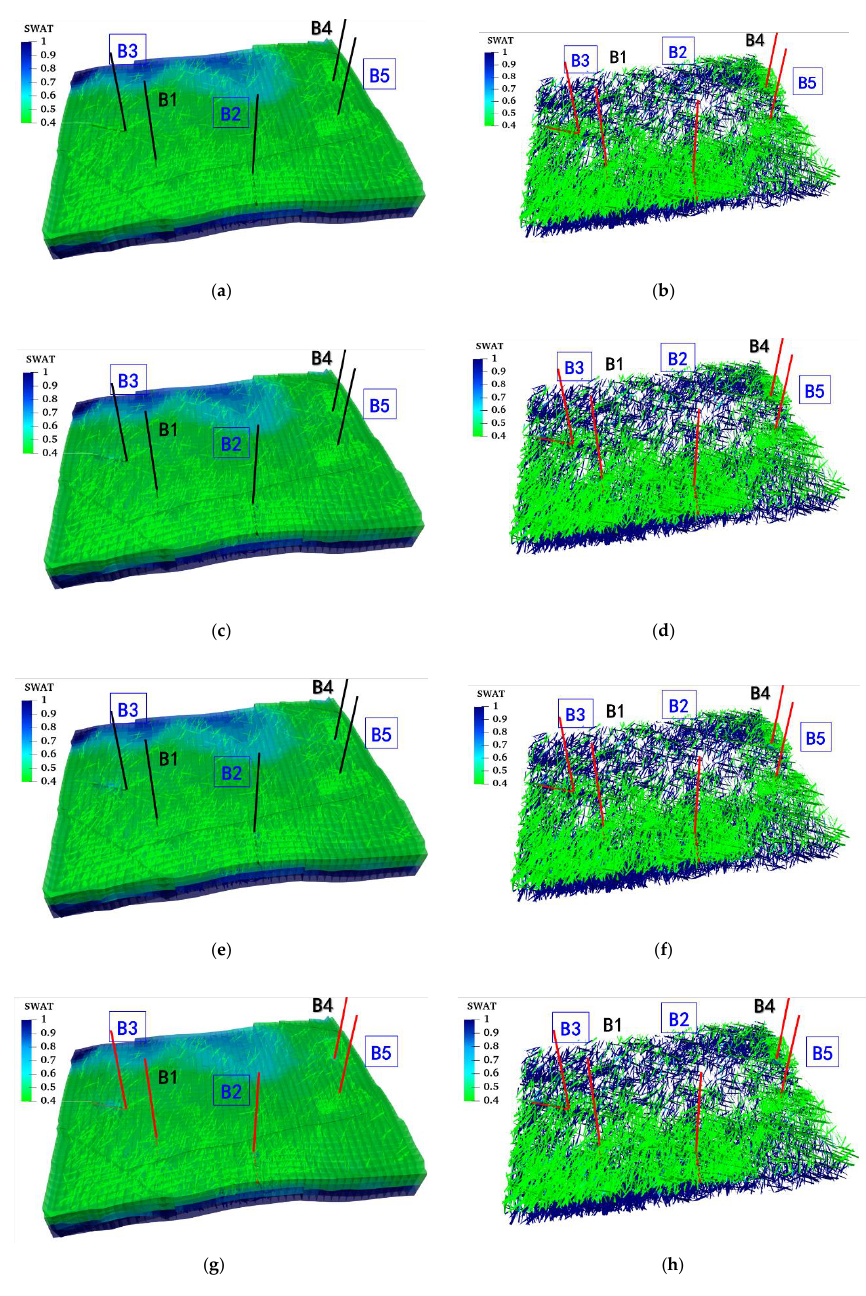
Figure 38. Detailed visualizations of reservoir water saturation in both matrix and fractures (left